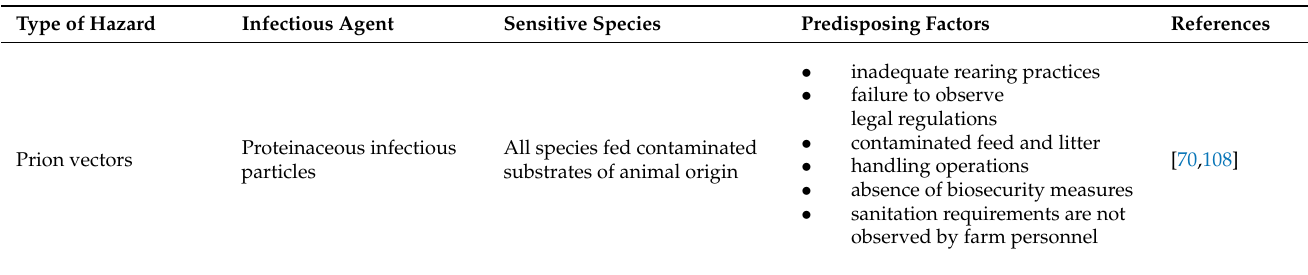
Table 2. Biological hazards associated with different species of edible